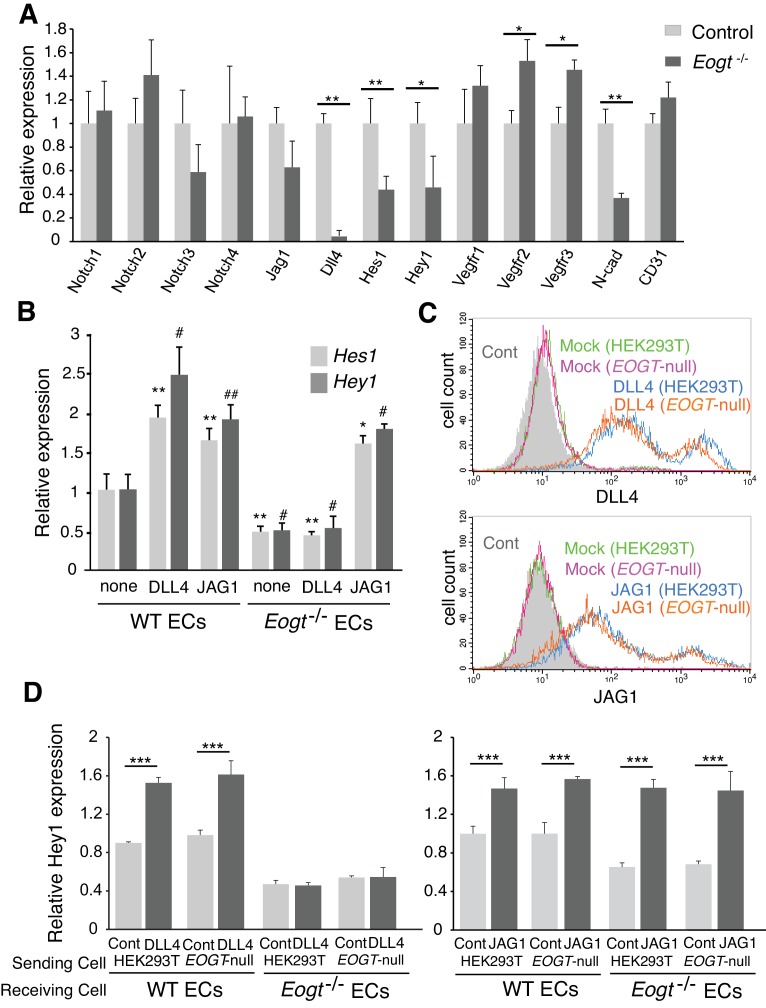
EOGT acts on Notch receptors to regulate ligand-induced Notch signaling in ECs.(A) Relative mRNA expression in purified brain EC cells. WT (gray) and Eogt−/− (dark gray) EC cells isolated from cerebrum using anti-CD31 antibody were analyzed for gene expression related to the Notch signaling pathway. Gene transcript levels were normalized to Gapdh. Data are mean ± S.D. from three independent experiments performed in triplicate. Each experiment analyzed pooled total RNA obtained from 10 mice. *p<0.05; **p<0.01 (Welch's t test). (B) qRT-PCR analysis of Hes1 and Hey1 in wild type or Eogt−/− lung EC cells following stimulation with immobilized DLL4-Fc or JAG1-Fc. Gene transcripts were normalized to Gapdh. Data are mean ± S.D. from three independent experiments performed in triplicate. Each experiment analyzed total RNA obtained from a single mouse. Significance determined by Welch's t-test. *p<0.05; **p<0.01; #p<0.05; ##p<0.01 compared with the left-most Hes1 (*) or Hey1 (#) histogram. (C) Cells were transfected to express Dll4 or Jag1 and subjected to flow cytometry using DLL4 or JAG1 antibody, respectively. Comparison with mock-transfected cells indicated the amount of exogenously expressed DLL4 and JAG1 on the cell surface in wild-type or EOGT-null HEK293T cells. Mock-transfected HEK293T cells were labeled without primary antibody (Cont.). (D) Dll4/Jag1-transfected cells or Mock transfectants (signal-sending cells) were co-cultured with wild type or Eogt−/− lung EC cells (signal-receiving cells). qRT-PCR analysis of mouse Hey1 expression suggested that EOGT is required for the ability to receive DLL4-mediated Notch signaling, and that EOGT is dispensable for DLL4 and JAG1 as inducers of Notch signaling. Gene transcript levels were normalized to PECAM1 (CD31). Data are mean ± S.D. from three independent experiments performed in triplicate. Significance determined by Welch's t-test. ***p<0.001.DOI:
http://dx.doi.org/10.7554/eLife.24419.02110.7554/eLife.24419.022Figure 8—source data 1.Raw data for Figure 8A,B,D.